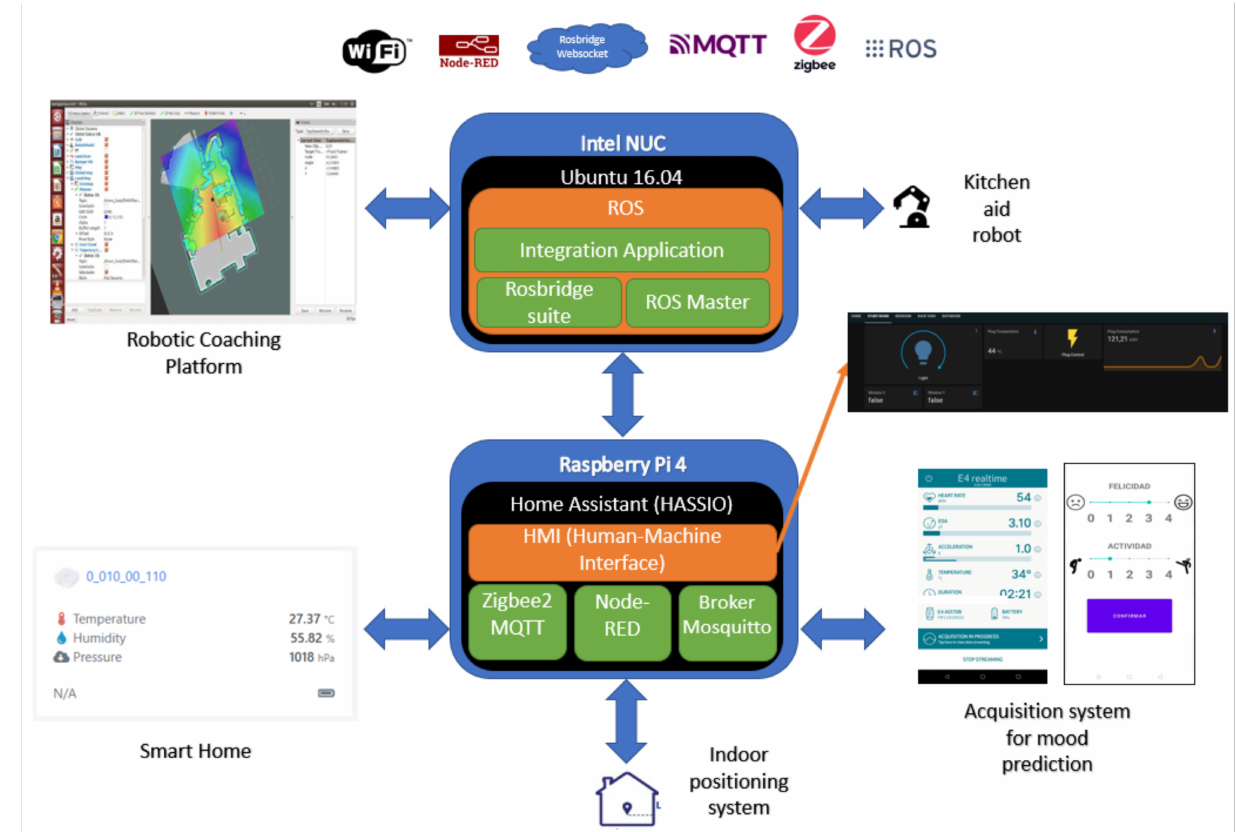
Figure 2. Software schematic of the